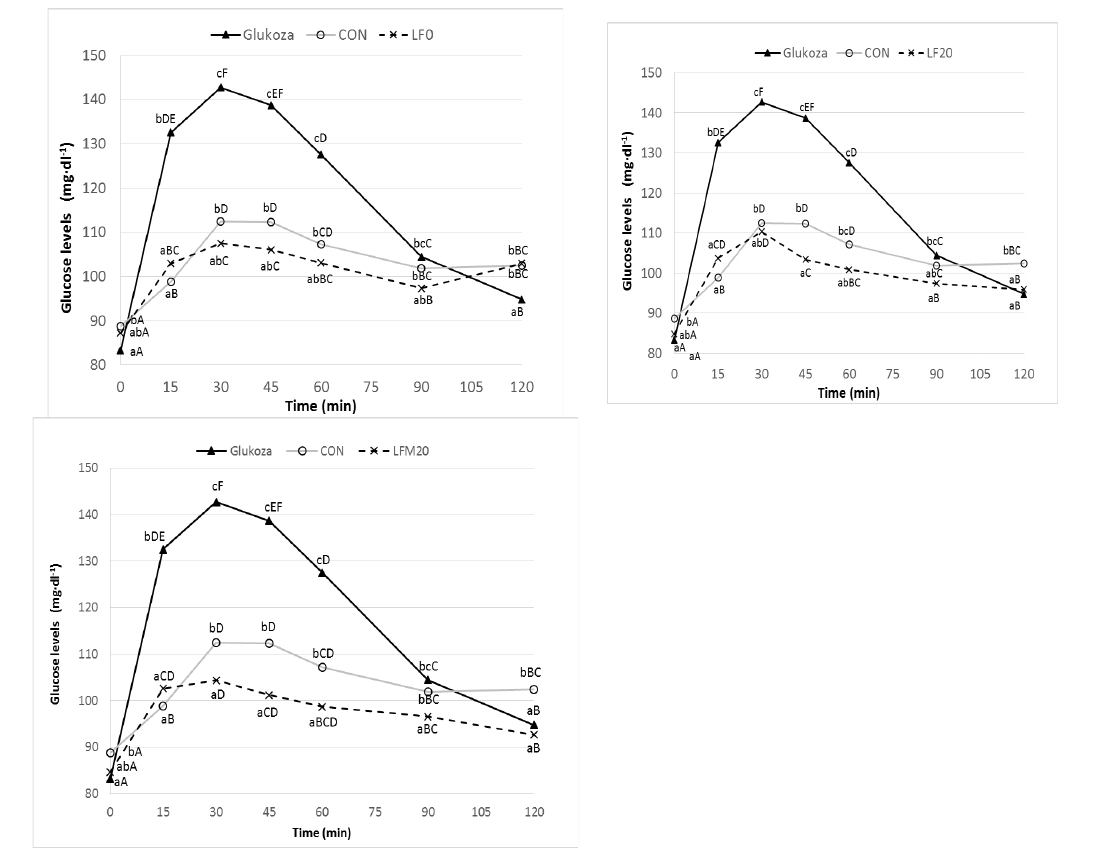
Figure 2. Postprandial glycemic curves after ingestion of standard glucose and pasta samples (CON, LF0, LF20 and LFM20). Explanation: CON, control sample; LF, lupin flour; LFM, lupin flour and millet flour; Data are presented as mean ( n = 10). Data values with different capital letters indicate statistically significant differences between glucose levels in time after ingestion; data values with different lowercase indicate statistically significant differences between glucose levels between glucose standard and pasta samples (Tukey test, p ≤